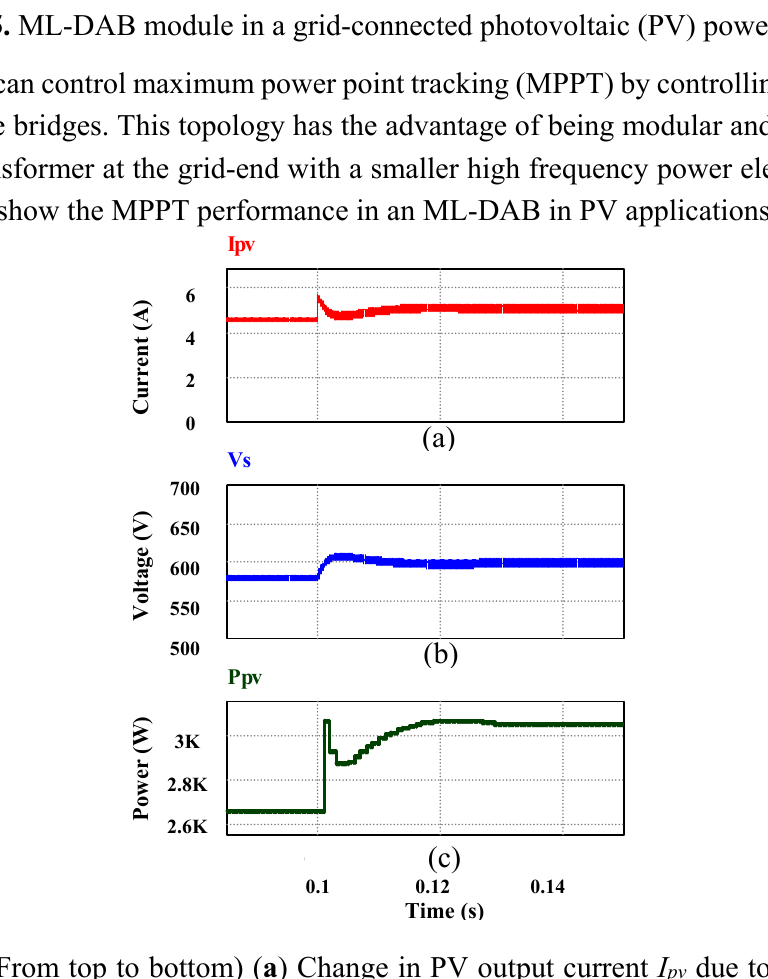
Figure 16. (From top to bottom) ( a ) Change in PV output current I pv due to the change in light intensity from 800 W/m 2 to 1,000 W/m 2 ; ( b ) corresponding change in voltage V pv because of maximum power point tracking (MPPT) and ( c ) power P pv